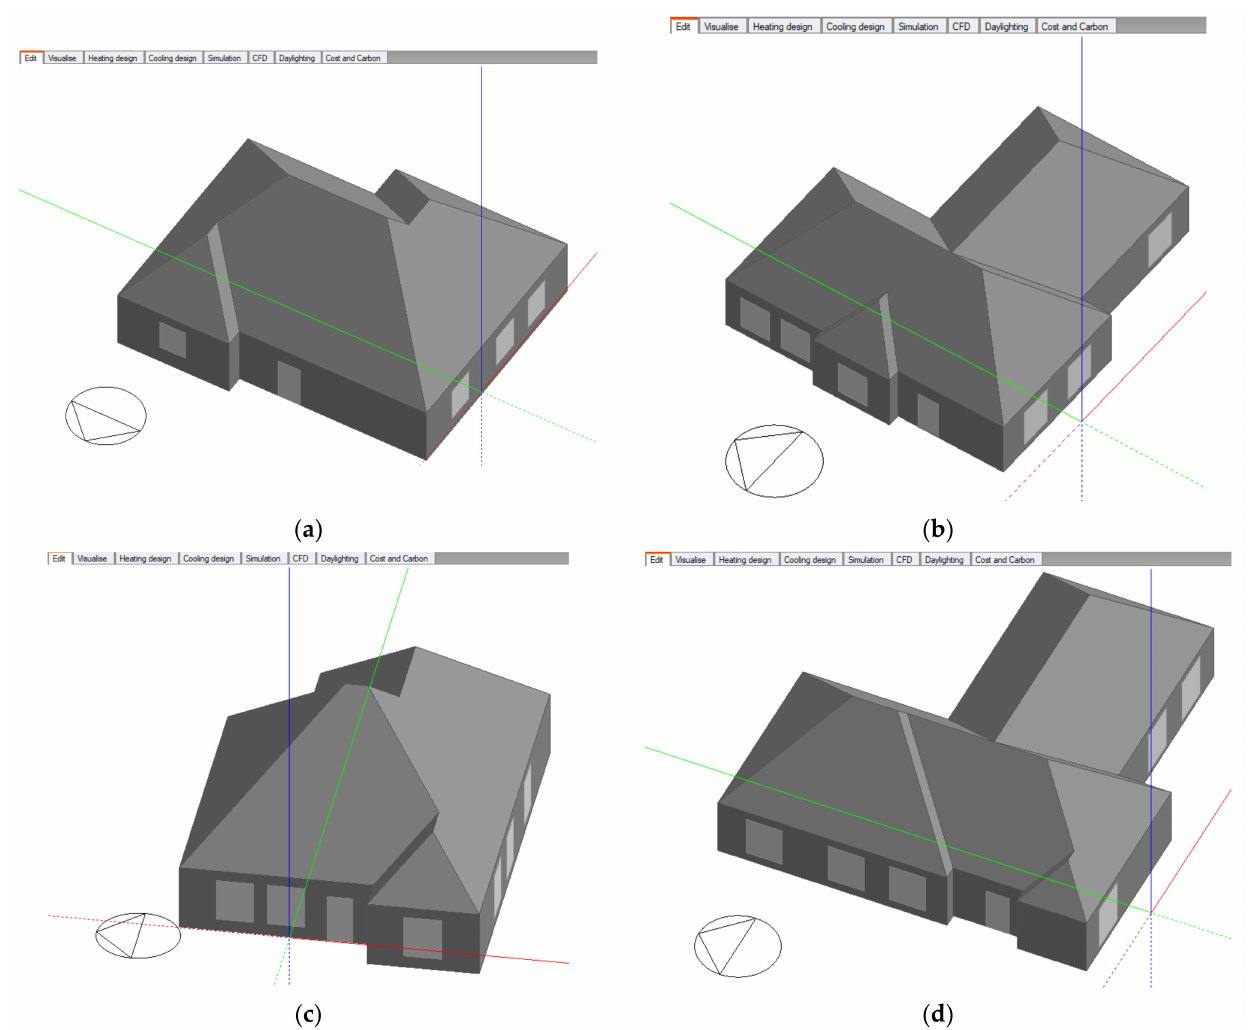
Figure 1. Visualization of example buildings: ( a ) H3; ( b ) H13; ( c ) H19; ( d )